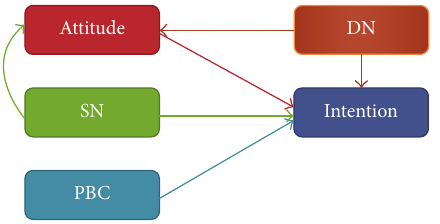
Figure 2: Impact of descriptive norm in TPB.